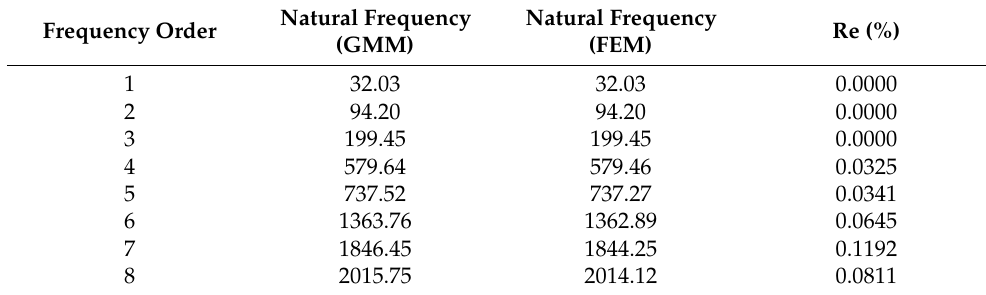
Table 1. First 8 order frequency of T-shaped beam structure (rad/s).